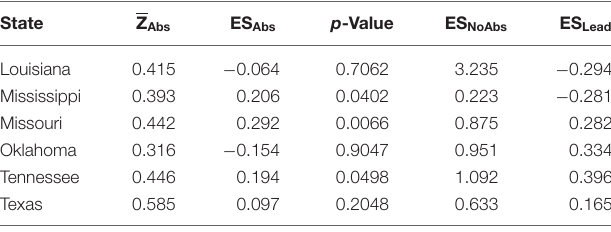
TABLE 2 | Overall synchrony with Arkansas ( N = 269).